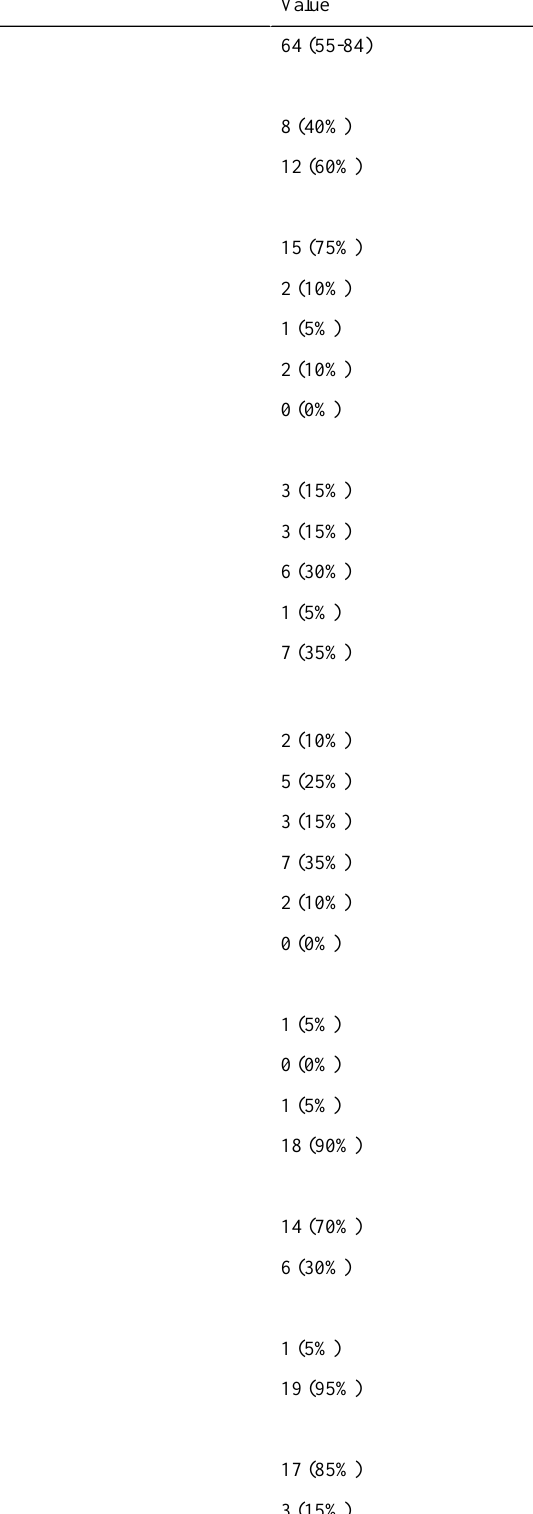
Table 3. Participant characteristics and previous technology